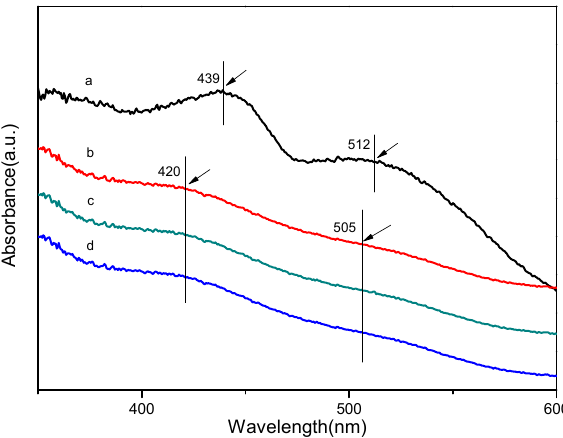
Figure 2. UV–vis spectra catalysts. ( a ) Chiral Mn III (salen) complex, ( b ) catalyst 1, ( c ) catalyst 2, ( d ) catalyst 3.